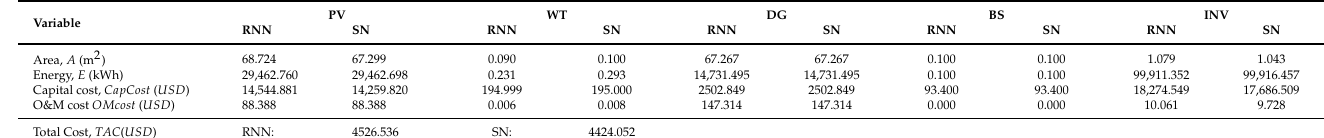
Figure 19. Optimization results for PV and BS using seasonal naive forecast. ( a ) PV output. ( b ) Energy stored in BS. Table 7. Results of the optimization run for both